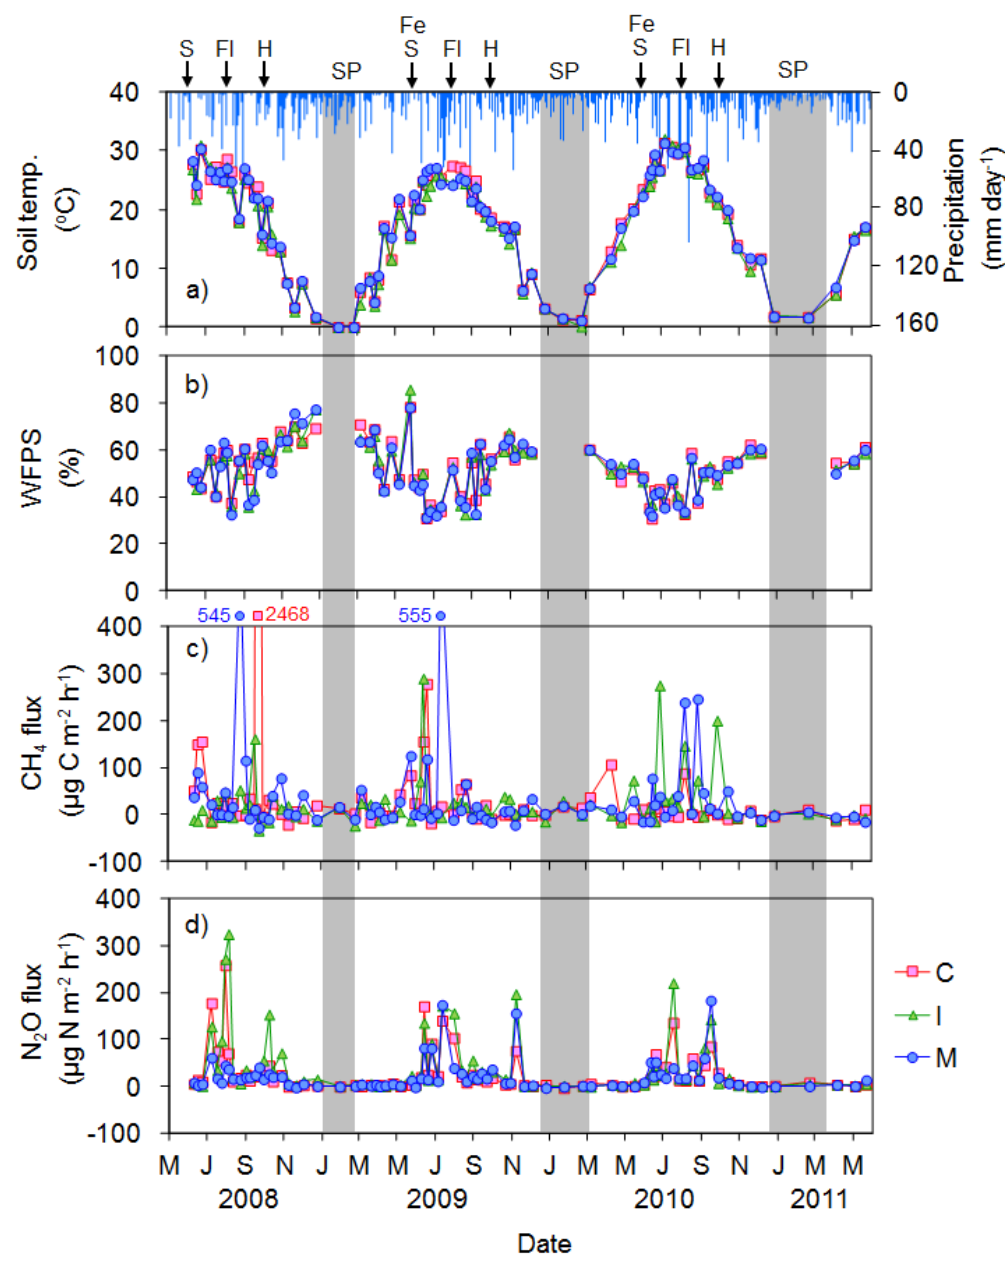
Figure 1. Seasonal changes in ( a ) soil temperature and precipitation (bars); ( b ) water filled pore space (WFPS); as well as ( c ) methane (CH 4 ) and ( d ) nitrous oxide (N 2 O) fluxes during the soybean cultivation period (upland). Positive flux values indicate emission to the atmosphere and negative indicate uptake from the atmosphere. C: control; Fe; Fertilizer application; Fl: flowering stage; H: harvesting; I: immature compost; M: mature compost; S: sowing; SP: snow period (gray area). During the soybean growing period after ridging, there was no significant difference in N 2 O fluxes from inter ‐ row and from on the rows, except for the immature compost plot, which had a tendency to have higher flux from those located on the rows (Figure 2, p > 0.05, paired t ‐ test, statistical data not shown).